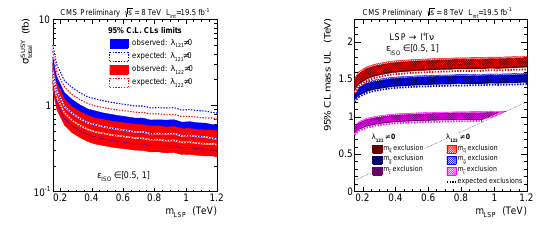
F igure 10. Left : 95% C.L. upper limit on total cross sections for generic SUSY models. The band corresponds to the e ffi - ciency uncertainty as described in the text. Right : Mass ex- clusions for di ff erent SUSY production mechanisms. Left : for T2 + LRPV models. Right : using a generic total RPV SUSY cross section limit in the left plot. A 30% theoretical uncertainty for NLO + NLL calculations of SUSY production cross sections is included in the uncertainty